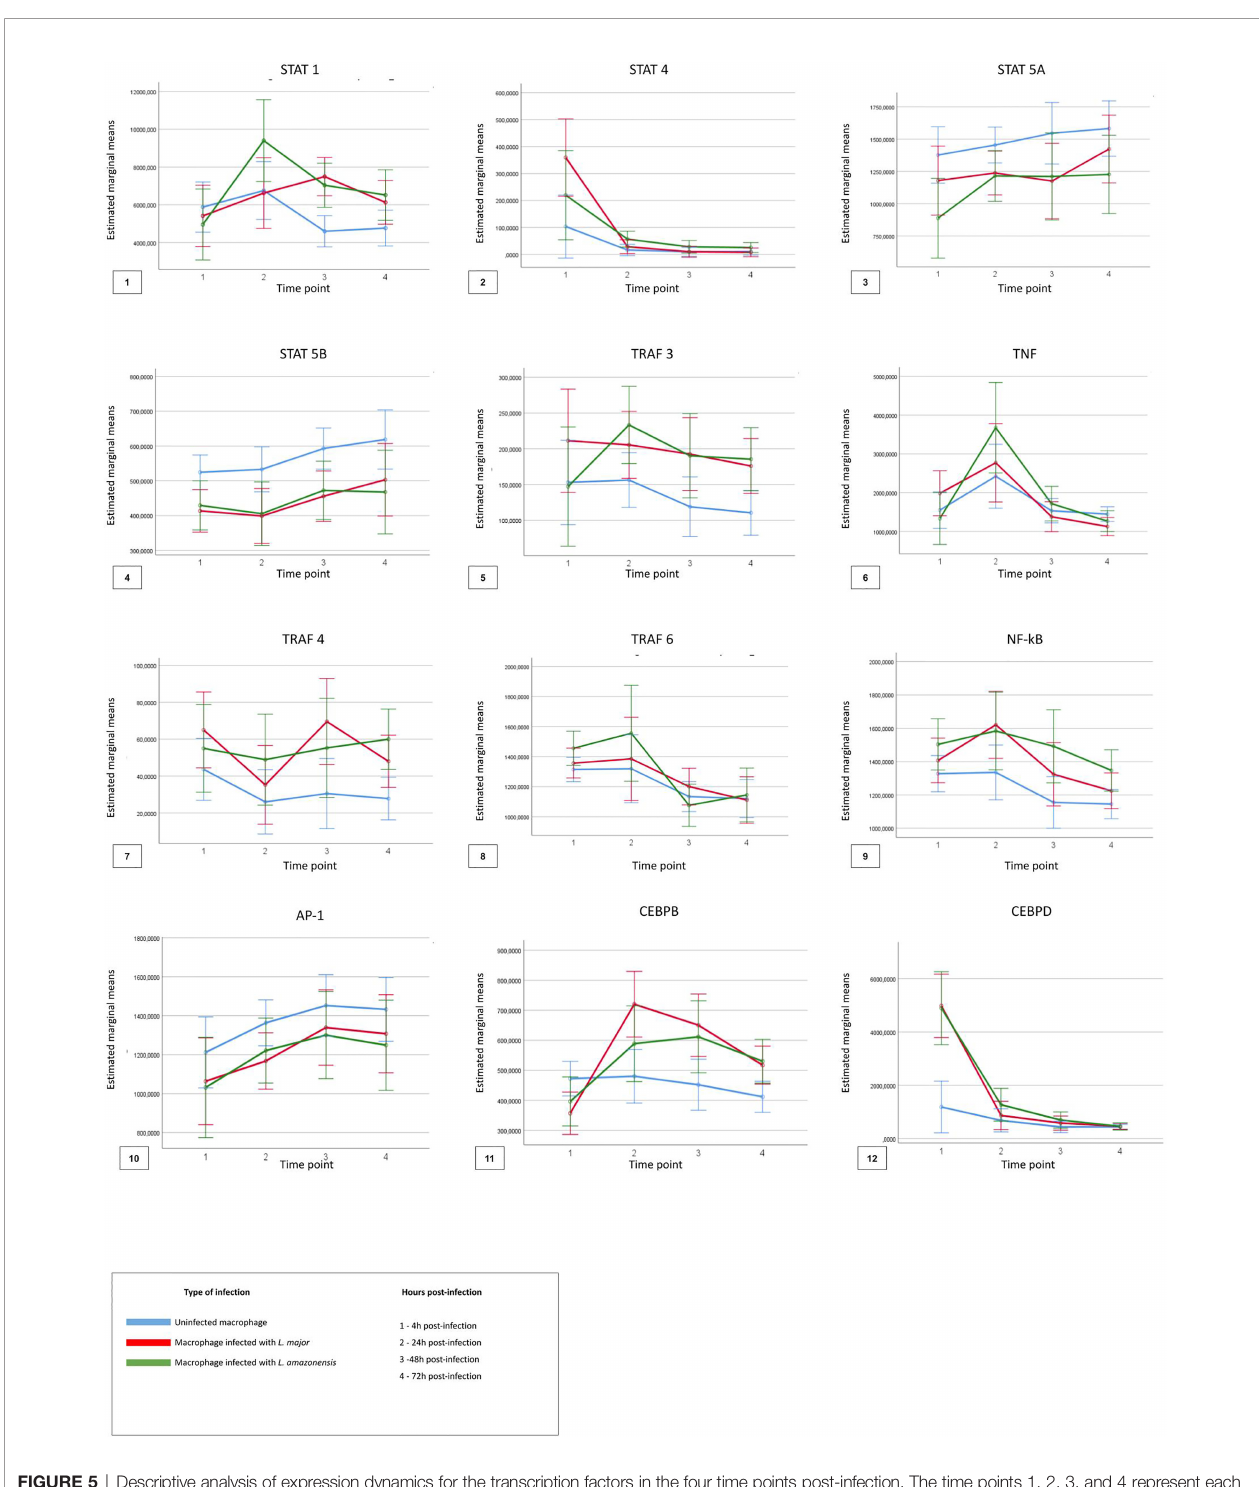
FIGURE 5 | Descriptive analysis of expression dynamics for the transcription factors in the four time points post-infection. The time points 1, 2, 3, and 4 represent each hour post-infection in the kinetics, respectively, 4 h post-infection, 24 h post-infection, 48 h post-infection, and 72 h post-infection. The blue lines represent uninfected macrophages, the red lines represent macrophages infected with Leishmania major , and the green lines represent macrophages infected with Leishmania amazonensis